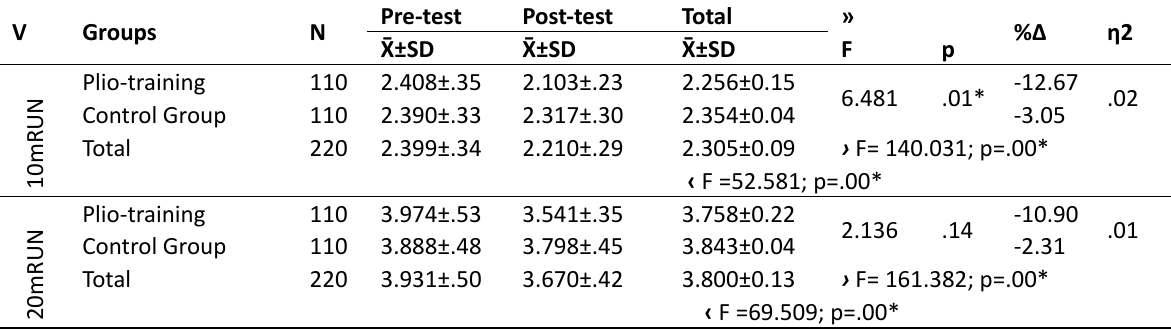
Table 4. Impact of plyometric training in acceleration ability factors